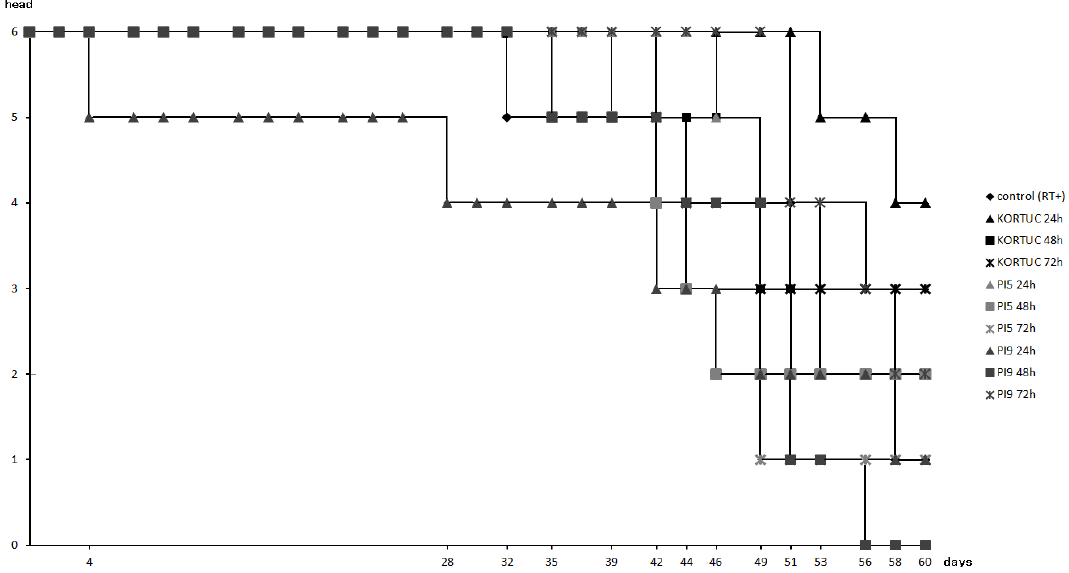
Figure 2. Survival rates of all groups. Survival rate was highest in the KORTUC (24 h) group (67%), followed by that in the KORTUC (72 h) group (50%). Survival rate was lowest (0%) in the PI9 (48 h) group. In addition, overall survival rate was 33% for four groups, and 16% for another three groups.